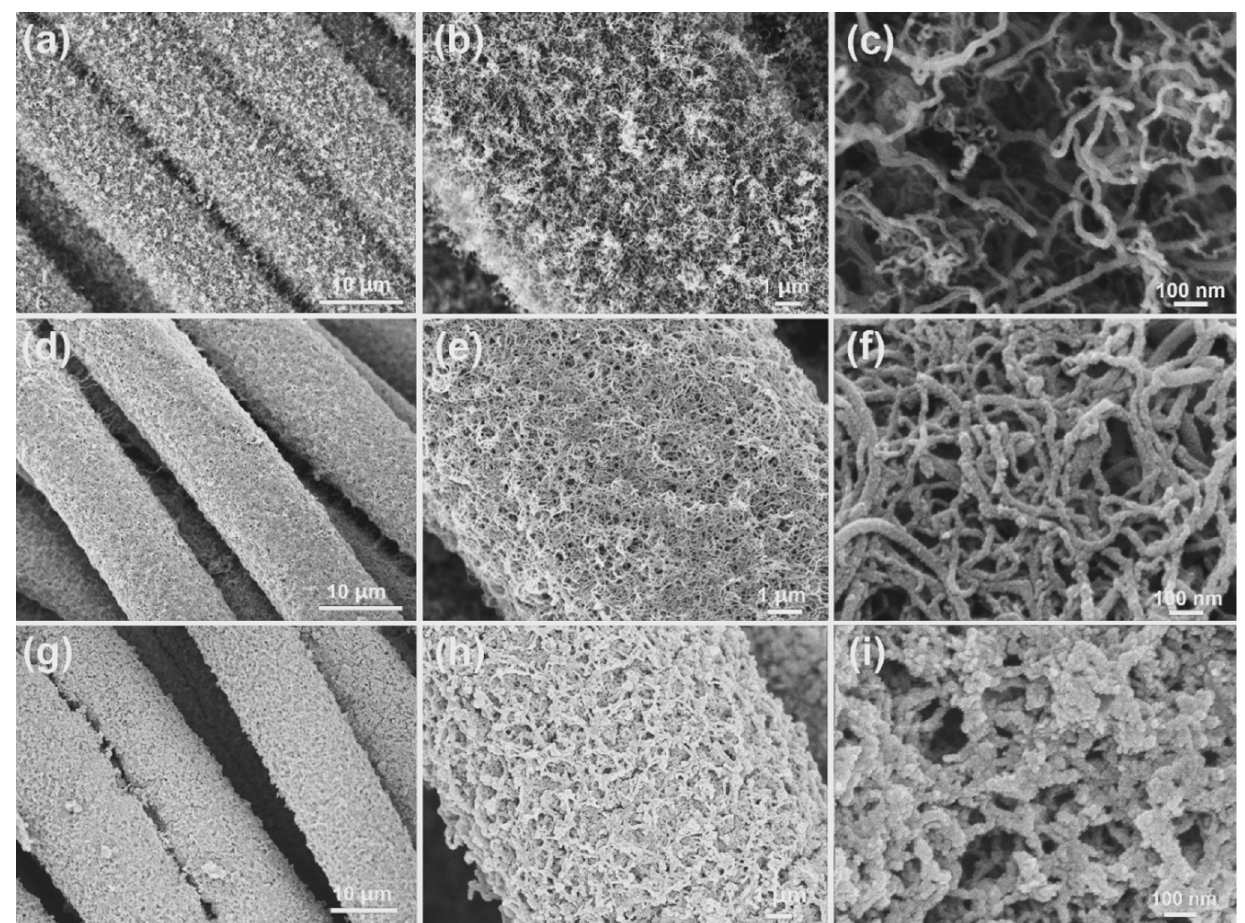
Figure 3. SEM images of ( a – c ) CNTs/CC, ( d – f ) α -MnO 2 @CNTs/CC, and ( g – i ) Fe 2 O 3 @CNTs/CC at different magnifications.